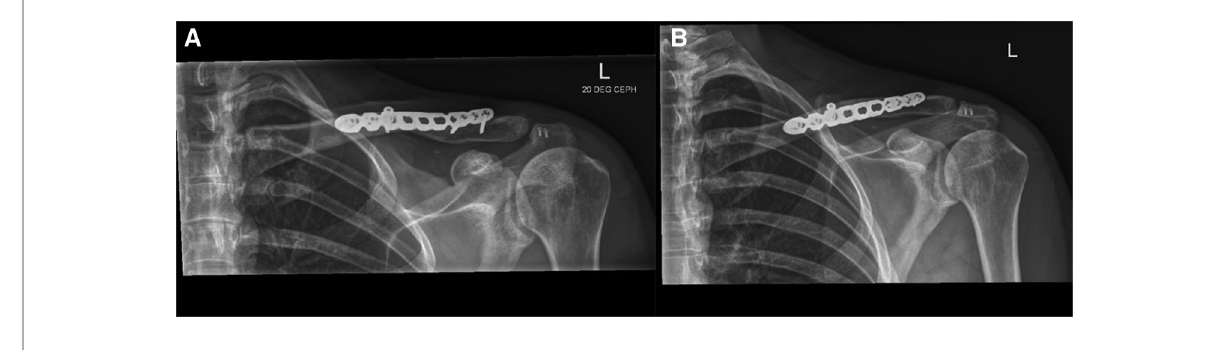
FIGURE 5. Radiographs demonstrating a united fracture and stable acromioclavicular joint post removal of hook